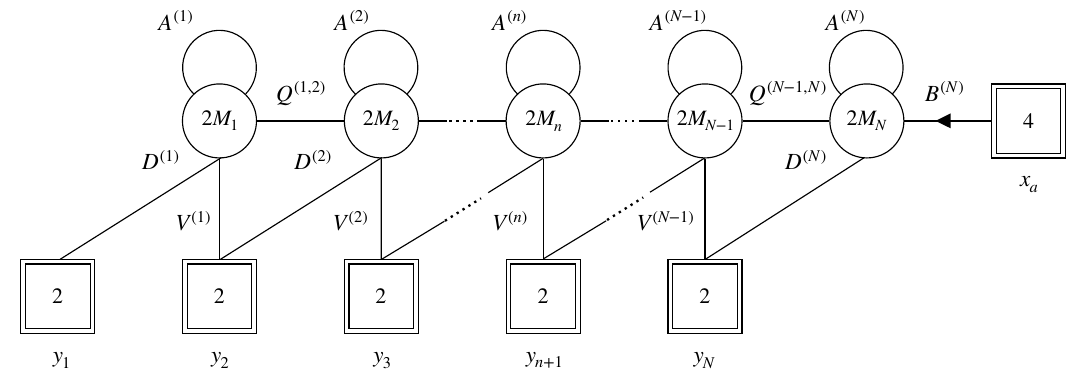
Figure 4 . Electric theory in the case of N gauge nodes. Singlet fields are not included in the